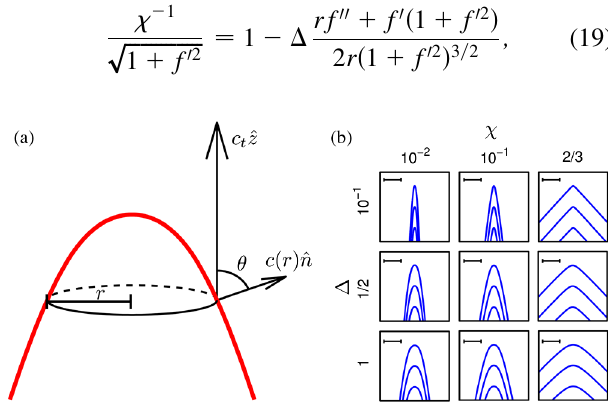
FIG. 4. A balance between curvature-driven growth and trans- lational growth sets the shape of a conical stromatolite. (a) When a curve f ð r Þ (red parabola) evolves due to curvature-driven growth, the normal velocity c is inversely proportional to the mean of the two radii of curvature at that point. When a curve translates forward, there is a geometric relationship between the and the speed at which it speed at which a point translates c t grows in the normal direction c . (b) The shape of the stromatolite depends on two parameters. (cid:10) (cid:2) 1 is the dimensionless speed of upward growth. The dimensional mat thickness (cid:1) gives the importance of curvature-driven growth. Values of (cid:1) are given relative to the thickness of the mat d 0 . The scale bar is 5 d 0